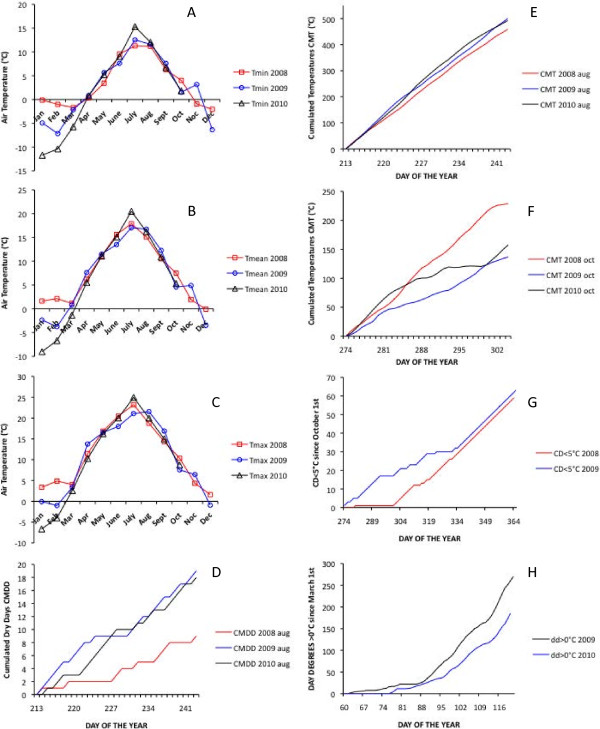
Meteorological variables at the field site in Ultuna (Sweden) during the three years of study and in relevant periods of time. Monthly minimum (a), mean (b), and maximum (c) temperatures; number of days with no rain (cumulated dry days, CMDD) since August 1st (d); cumulative sums of daily mean temperatures (CMT,°C) during August (e) and October (f); number of chill days (CD) with mean temperature below 5°C (g); cumulated mean temperatures above 0°C (day degrees>0°C) from March 1st to bud burst (h).